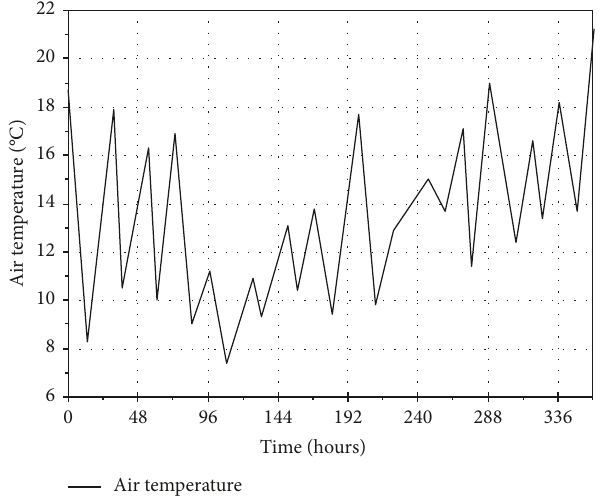
Figure 3: Temperature history of ambient